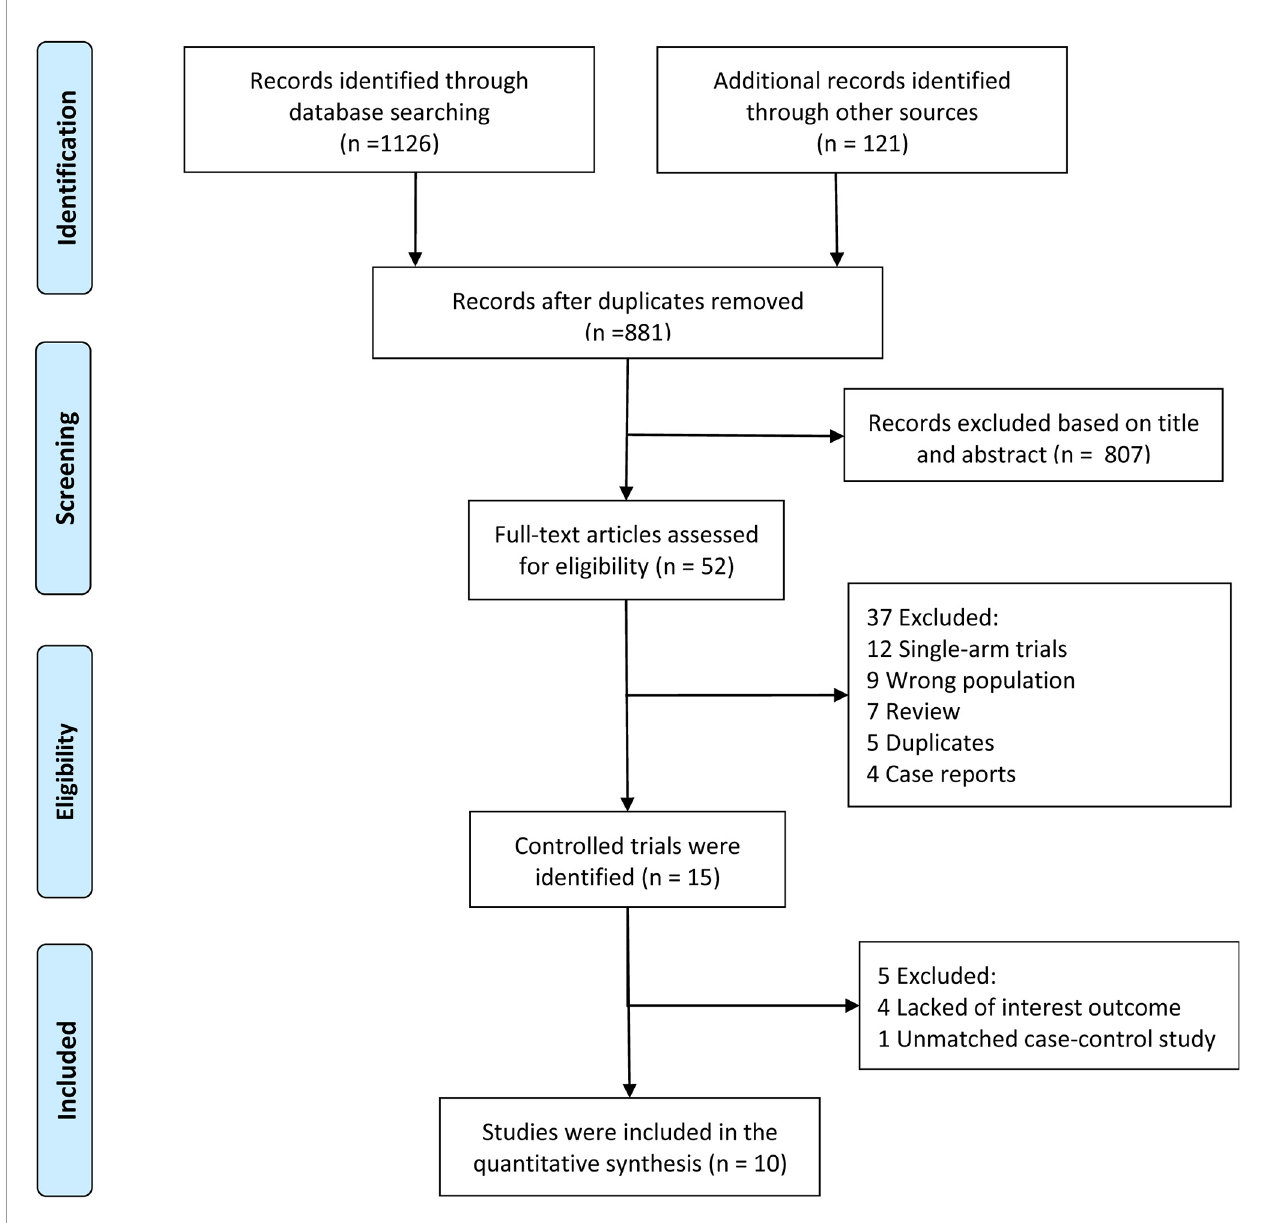
FIGURE 1 | Flow chart of study